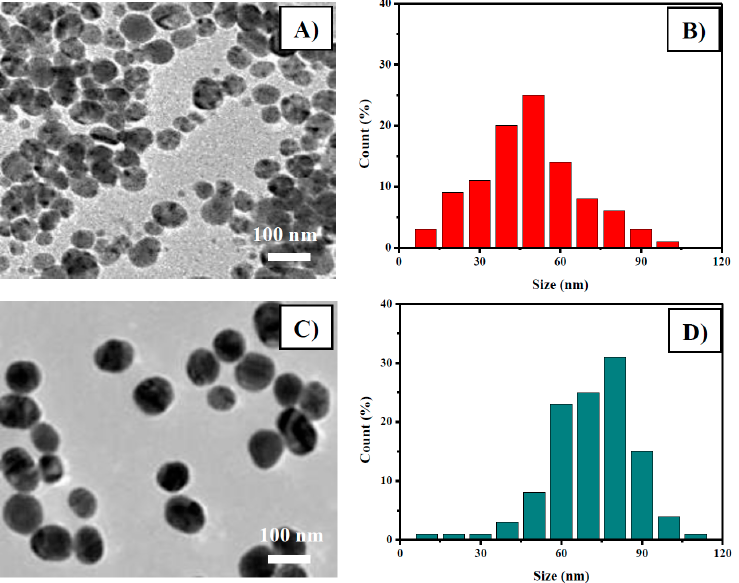
Figure 2. Transmission electron microscopy (TEM) of ( A ) AgNPs and ( C ) AuNPs. Particle size distribution of ( B ) AgNPs and ( D ) AuNPs. DLS was also used for analyzing the size distribution of the synthesized Ag and Au nanoparticles in aqueous suspension. Differently from UV-Vis and TEM data, by this tech- nique, we can determine the secondary particle size of nanoparticles dispersed in a spe- cific polar or non-polar solvent [38]. DLS spectra of AgNPs and AuNPs redispersed in the aqueous solution are shown in Figure 3. The plot shows the volume (percent) of particle